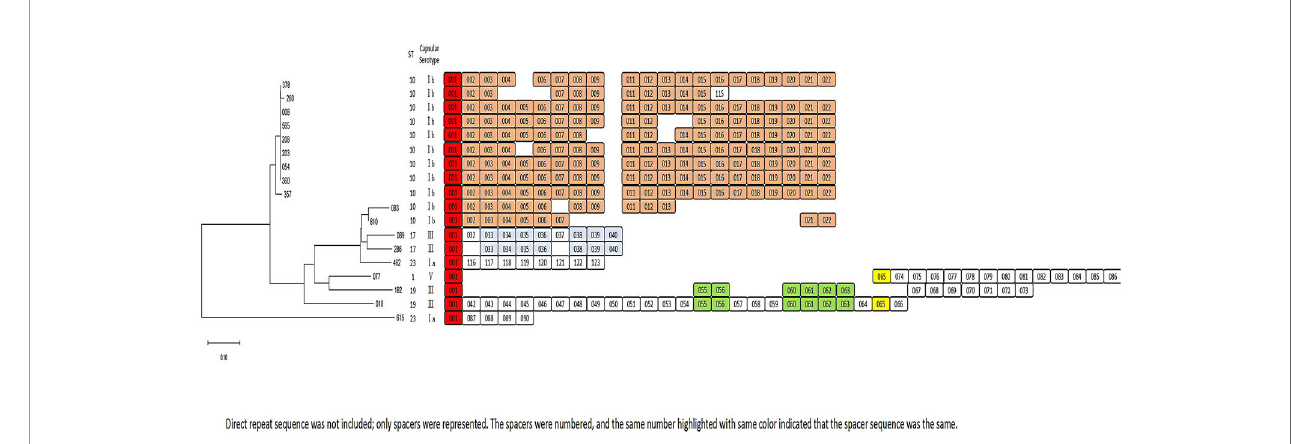
FIGURE 2 | Dendrogram constructed from the CRISPR1 pro fi les of GBS strains.